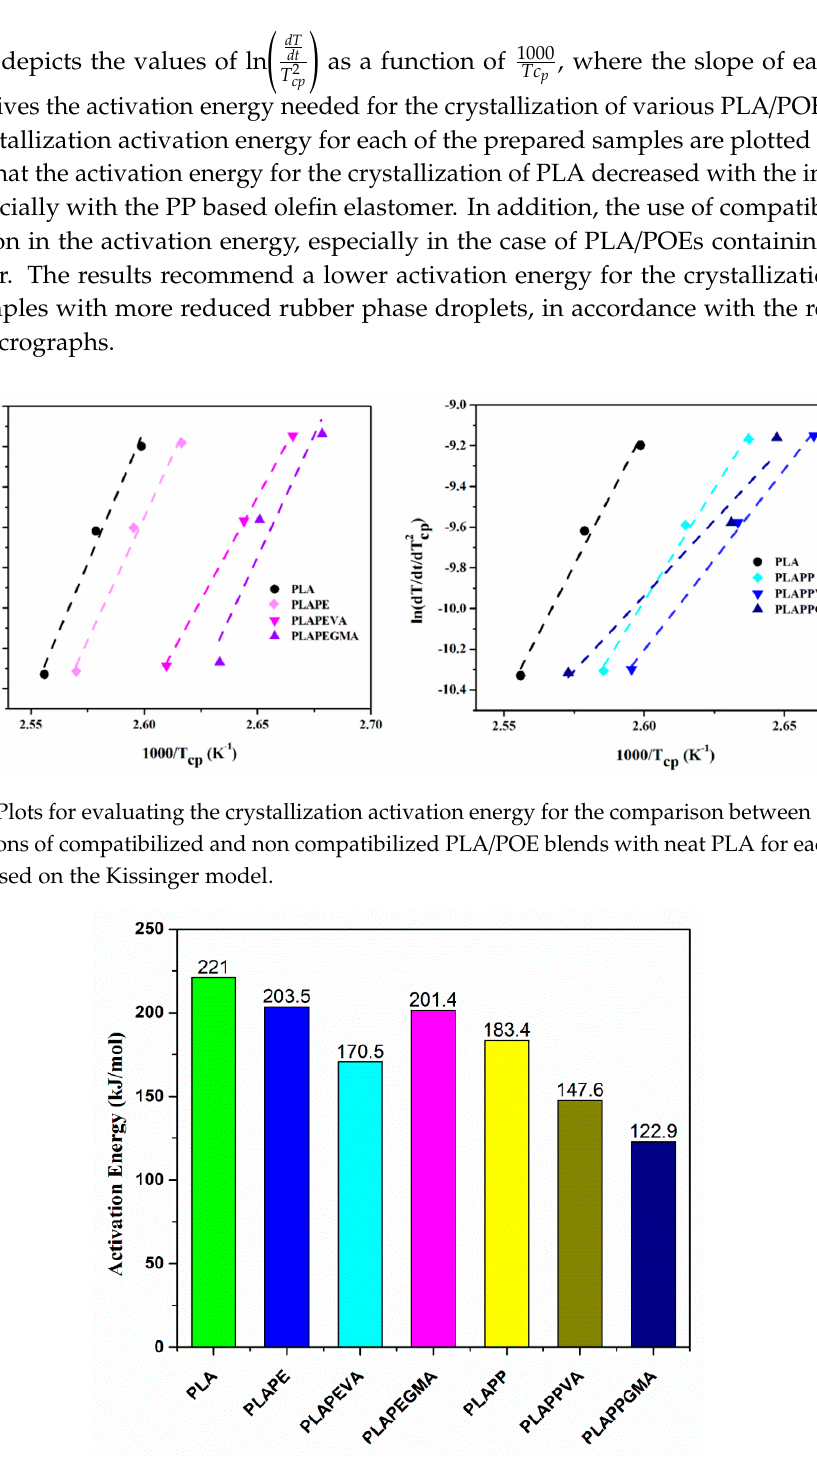
Figure 10. Nonisothermal crystallization activation energy for various PLA/POEs based on the Kissinger Kissinger model.